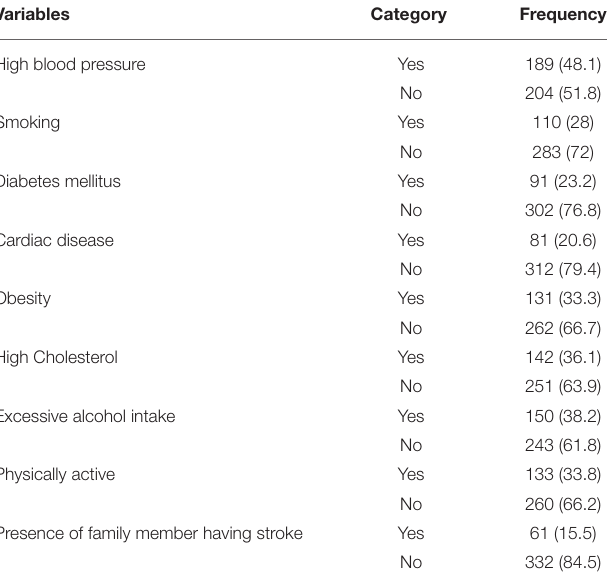
TABLE 4 | Stroke risk factors of patients attending in chronic illness follow-up Clinic of University of Gondar Comprehensive Specialized Hospital, Northwest, Ethiopia, 2021 ( n = 393).